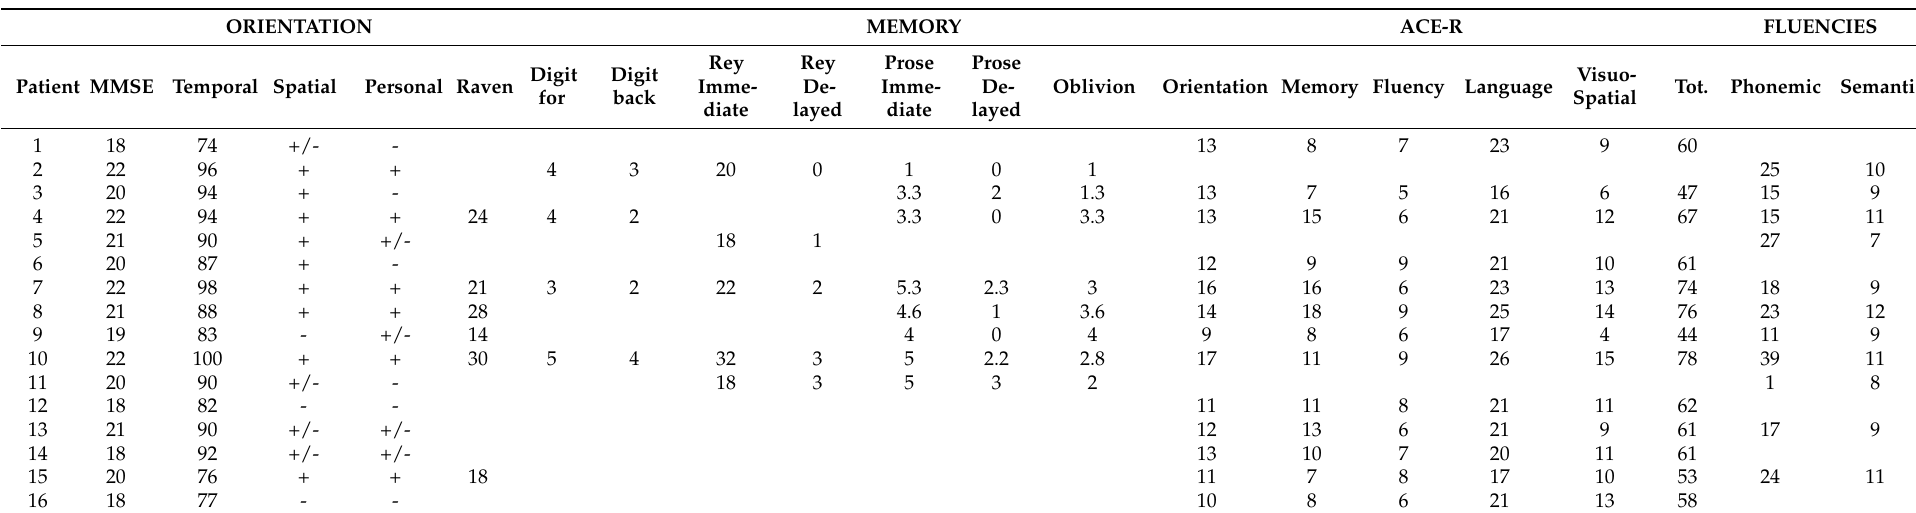
Table 2. Neuropsychological tests’ scores in AD-type patients.